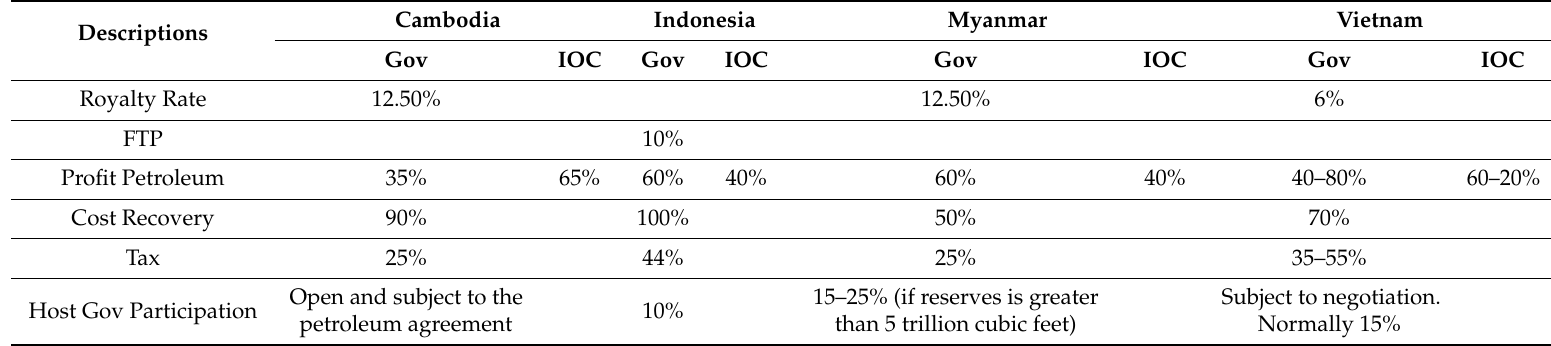
Table 4. Main Fiscal Parameters of Myanmar, Cambodia, Indonesia, and Vietnam.